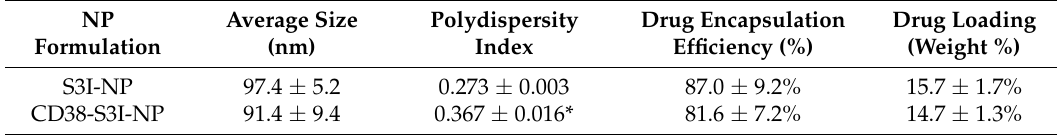
Figure 1. The synthesis of CD38-S3I-NP. ( A ) Chemical reactions of the anti-CD38 conjugation to PEO- b -PBCL, the building block of our nanoparticles (NP). The final product was mixed with S3I-NP to generate CD38-S3I-NP. ( B ) The release of S3I-1757 from S3I-NP or CD38-S3I-NP in vitro. The percentage of S3I-1757 released was calculated by the lost amount of S3I-1757 compared to the initial total amount of S3I-1757. The error bar represents the standard deviation from a triplicate experiment; * p < 0.05, via Student’s t -test. Table 1. Physical properties of S3I-NP and